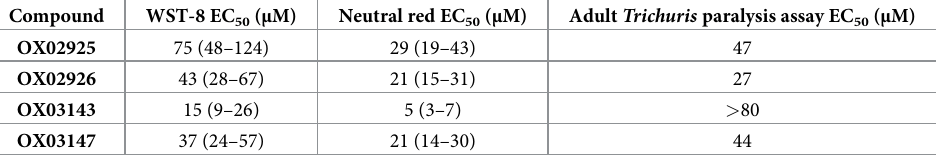
Table 1. Summary of the cytotoxicity in a mouse epithelial cell line of the DATP series. Mouse CMT-93 rectal epi- thelial cells were used for this assay. Maximum tested concentration was 100 μM. n = 8, error range (in parentheses) shows 95% confidence interval. EC 50 values in the adult Trichuris paralysis assay are shown for